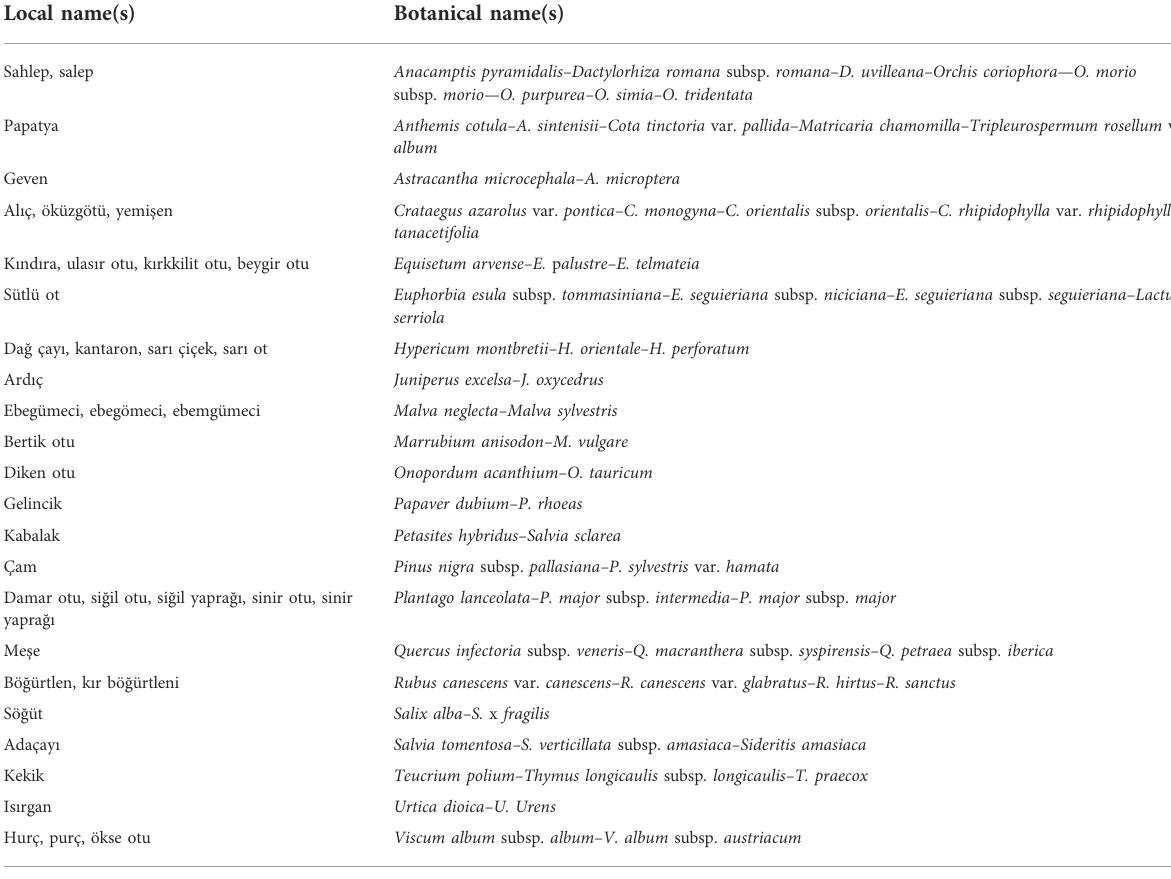
TABLE 5 The same vernacular name(s) used for more than one plant